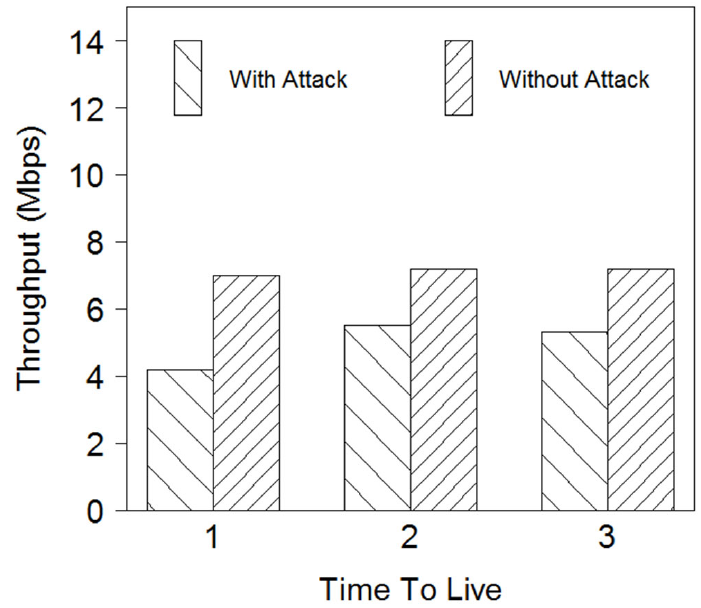
Figure 12. TTL vs. throughput with 30% blackhole nodes.